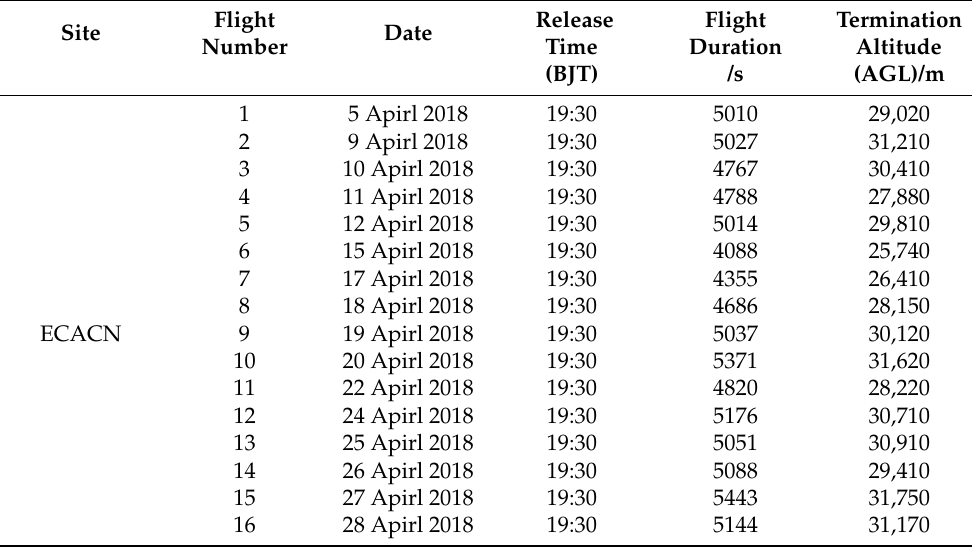
Table A1. ECACN radiosonde details (BJT: Beijing time).